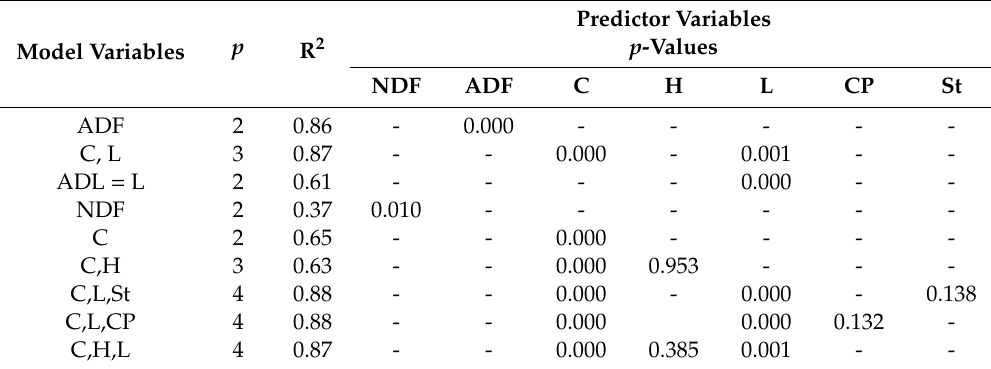
Table 3. Number of parameters (p), coefficient of determination (R 2 ), and significance ( p -values) for the estimation of biodegradability from different plant components.